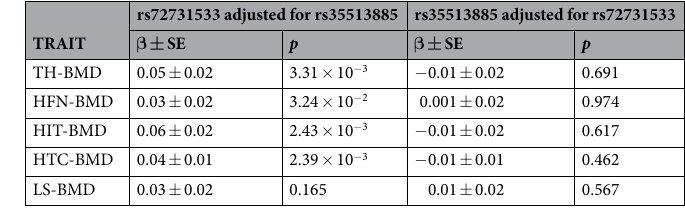
Table 4. Conditional association analysis using rs35513885 and rs72731533. TH-BMD: total hip BMD; HFN- BMD: hip femoral neck BMD; HIT-BMD: hip intertrochanter BMD; HTC-BMD: hip trochanter BMD; LS- BMD: lumbar spine BMD; β : estimates of effect size expressed as adjusted SD per copy of the effect allele; SE: standard error of β ; p : p-value in the conditional